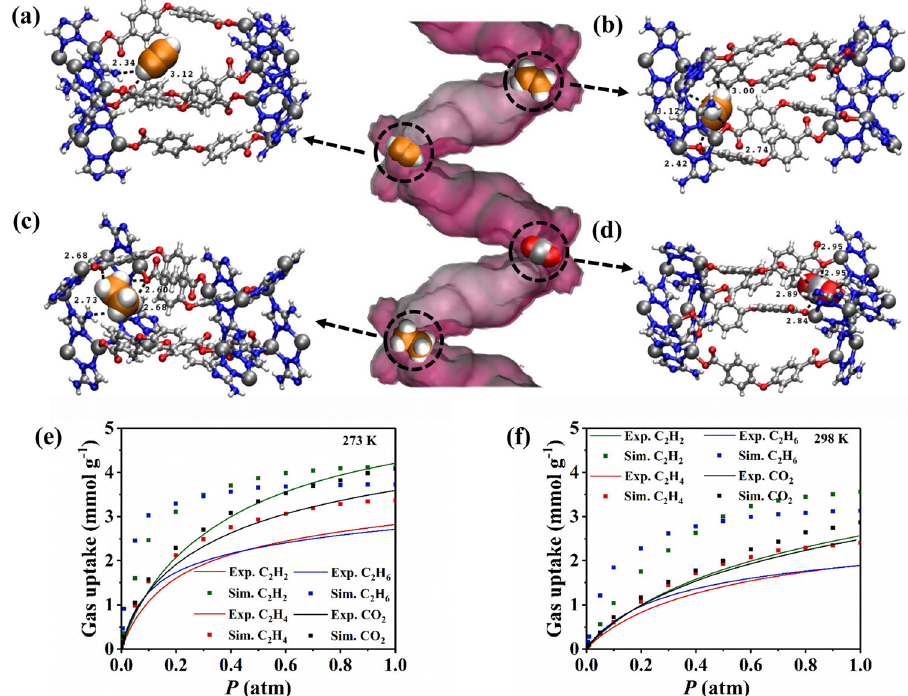
Fig. 3 Molecular modeling guided determination of primary adsorption sites and adsorption isotherms in Zn-atz-oba. The primary adsorption sites of ( a ) C 2 H 2 , ( b ) C 2 H 4 , ( c ) C 2 H 6 , and ( d ) CO 2 in Zn-atz-oba. Adsorbed gas molecules are presented in space- fi lling mode. color codes: C (Zn-atz-oba and CO 2 ): gray; C (C2 gases): orange; H: white; O: red; N: blue; Zn: silver. Experimental (solid lines with circles) and simulated (squares) adsorption isotherms for C 2 H 2 (green), C 2 H 4 (red), C 2 H 6 (blue), and CO 2 (black) at ( e ) 273 K and ( f ) 298 K and pressures up to 1 atm in